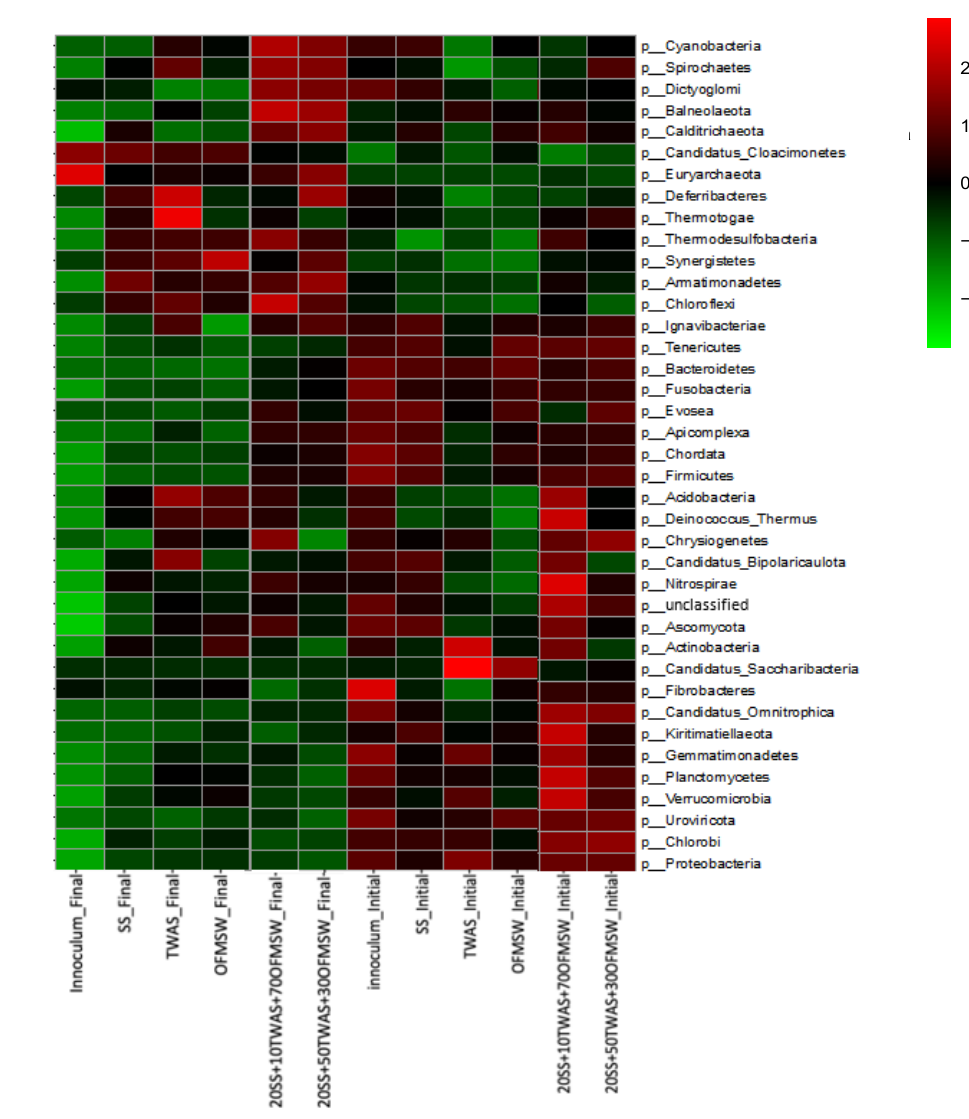
Figure 3. Heatmap of the top 40 phyla in both the initial and final phases of this study .